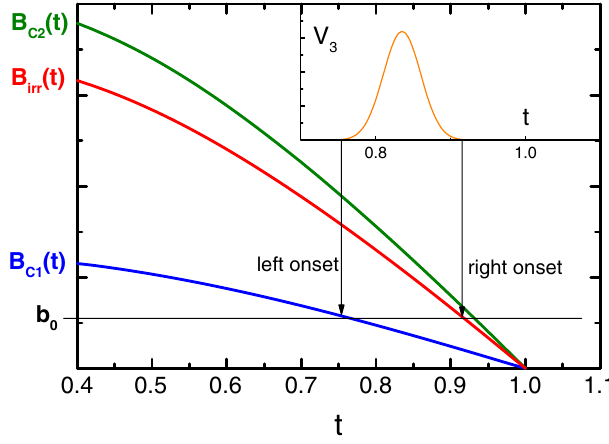
FIG. 6. Principle of third harmonic analysis (see text for de- tails). t ¼ T=T C